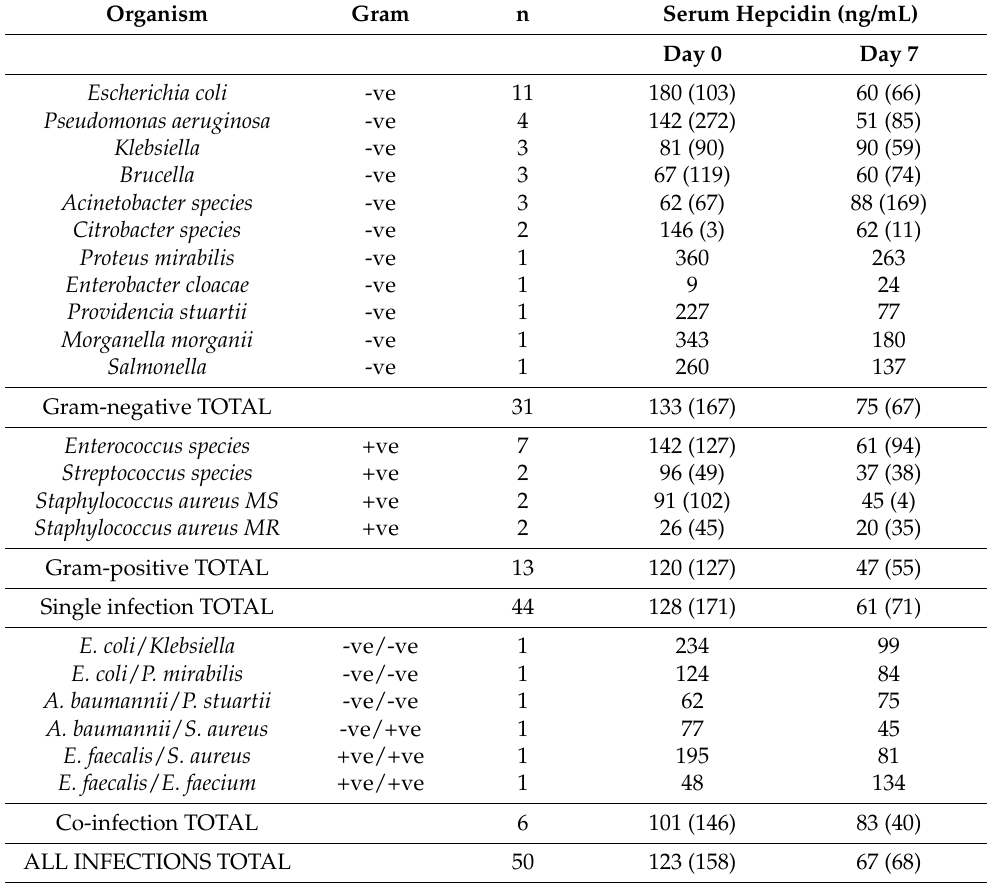
Figure 1. Comparison between healthy subjects and bacteremia patients on day 0 or 7. Serum Hepcidin ( A ), Serum Ferritin ( B ), Hepcidin /log Ferritin ( C ), and Serum CRP ( D ) in the studied groups. ns: non-significant; **: p < 0.005; ****: p < 0.0001. Table 2. Blood culture results. Values represent the median (IQR) when number of cases (n) > 3 and mean (range) when n ≤